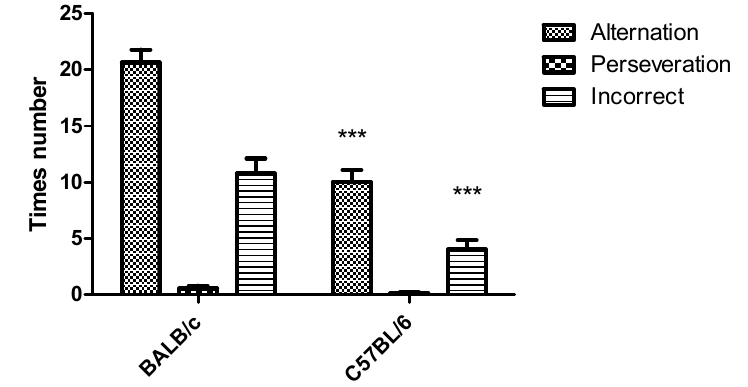
Figure 4. Response to Y-maze task (three arms free) for strains BALB/c and C57BL/6 mice. Data shows mean ± standard deviations for the number of alternation, perseveration or incorrect entries to the arms. * Represents significant differences between the two strains for p ˂ 0.05 according to one-way ANOVA and the Tukey post hoc test.